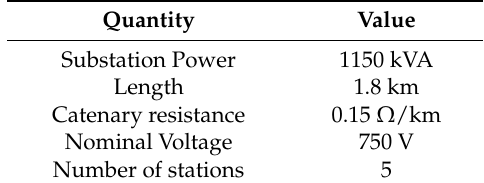
Table 2. Parameters of the electrical railway system.